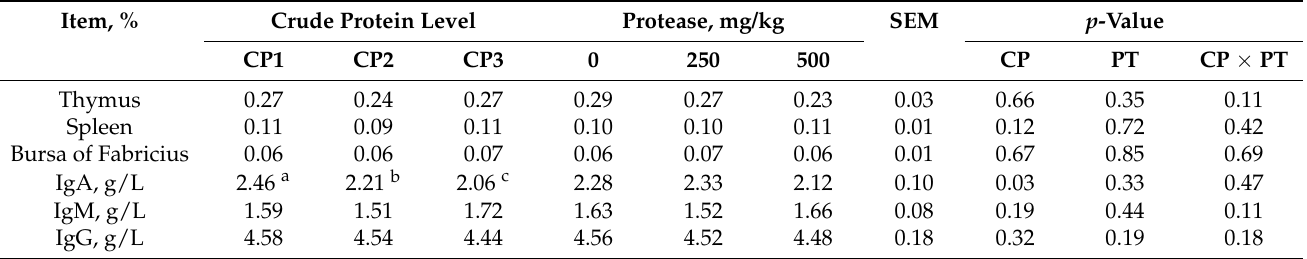
Table 6. Effects of dietary crude protein and protease levels on immune organ indices and serum immunoglobulins of broilers.